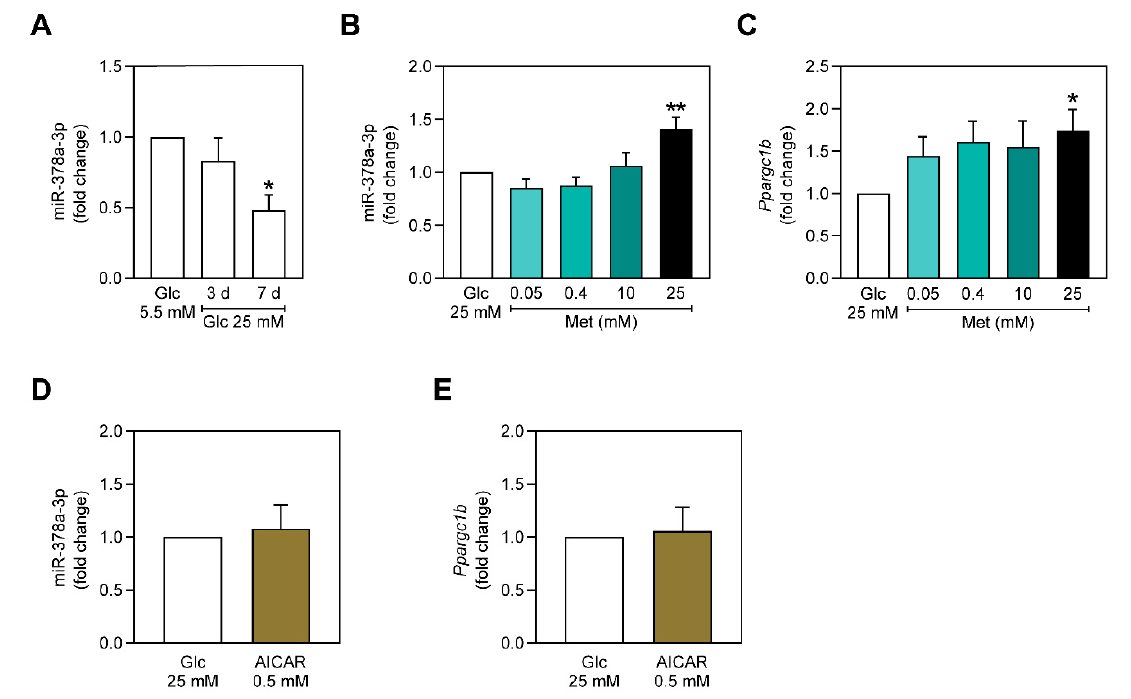
Figure 1. Higher concentrations of metformin upregulate miR-378a-3p and Ppargc1b in C2C12 myoblasts independently of AMPK. ( A ) miR-378a-3p expression in C2C12 cells after being exposed to 25 mM glucose for 3 and 7 days. ( B ) miR-378a-3p and ( C ) Ppargc1b expression in C2C12 myoblasts incubated with 0.05, 0.40, 10 and 25 mM of metformin. ( D ) miR-378a-3p expression and ( E ) Ppargc1b expression after incubation with 0.5 mM AICAR. All data is given as mean ± S.E.M. ( n = 3). * p < 0.05, ** p = 0.0019 vs. Glc 25 mM.